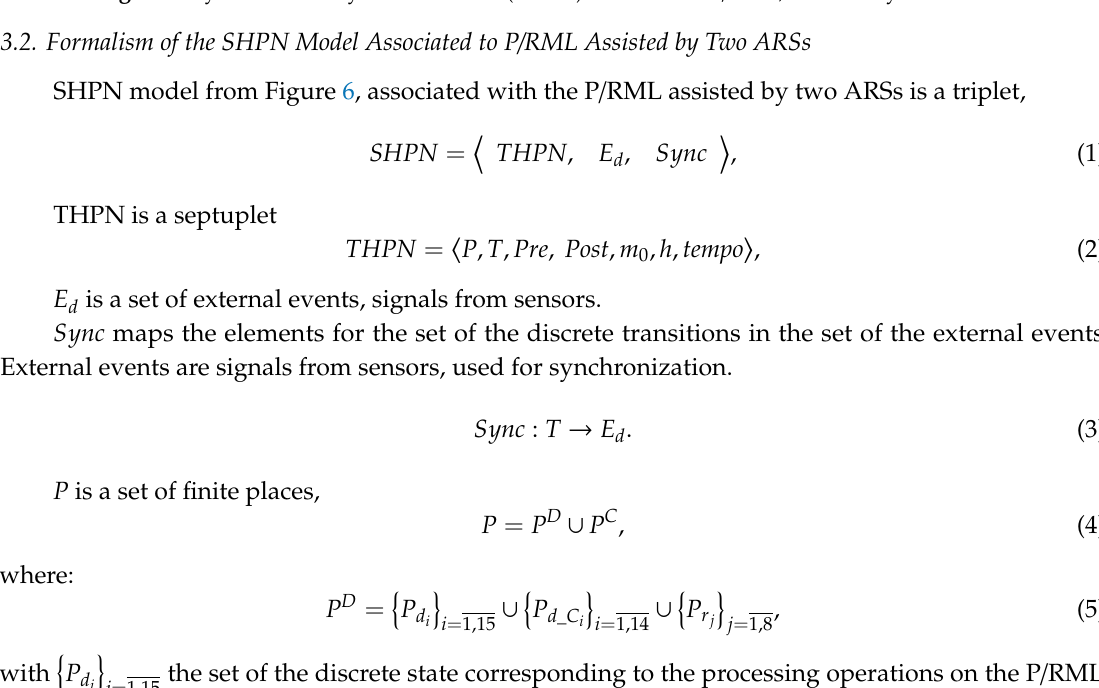
Figure 5. synchronized hybrid Petri nets (SHPN) structure of P/RML, assisted by two ARSs.